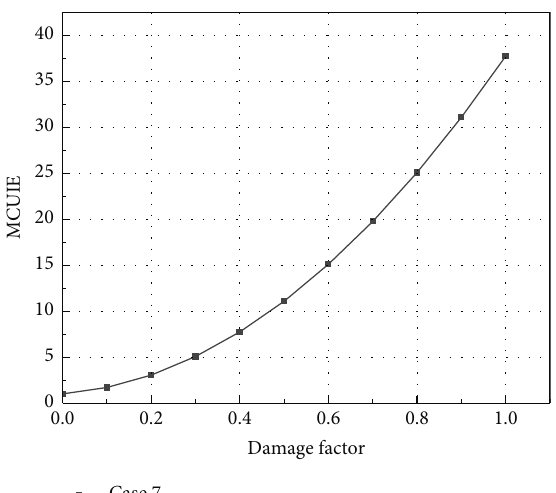
Figure 26: Damage degree fitting curve of case